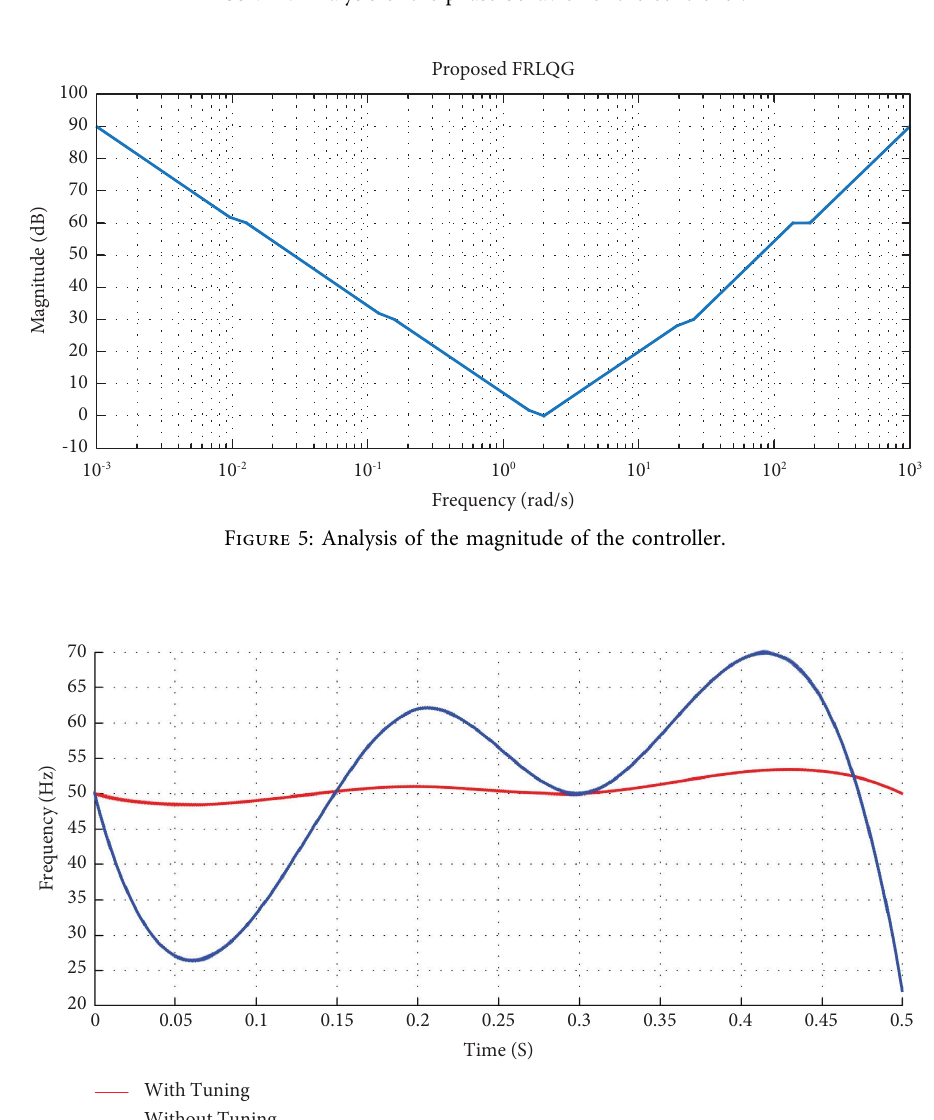
Figure 4: Analysis of the phase behavior of the controller.